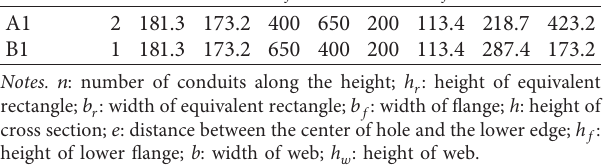
Table 4: Dimensions of I-shaped section (millimeters). Specimen